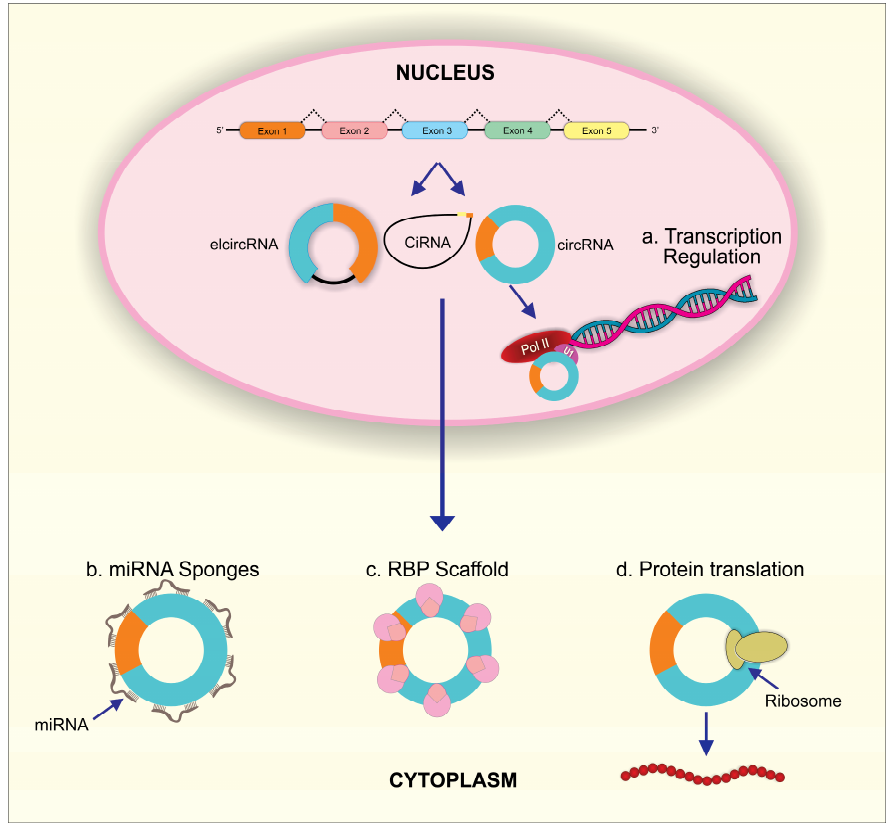
Figure 2. The biological functions of circRNAs. ( a ) In the nucleus, circRNAs can regulate parent RNA transcription through combining with U1 snRNP and then interacting with Pol II. In the cytoplasm, ( b ) circRNAs can act as miRNA sponges to inhibit miRNA activity; ( c ) circRNAs can scaffold RBPs to regulate post-transcriptional process; ( d ) circRNAs can initiate protein translation by recruiting